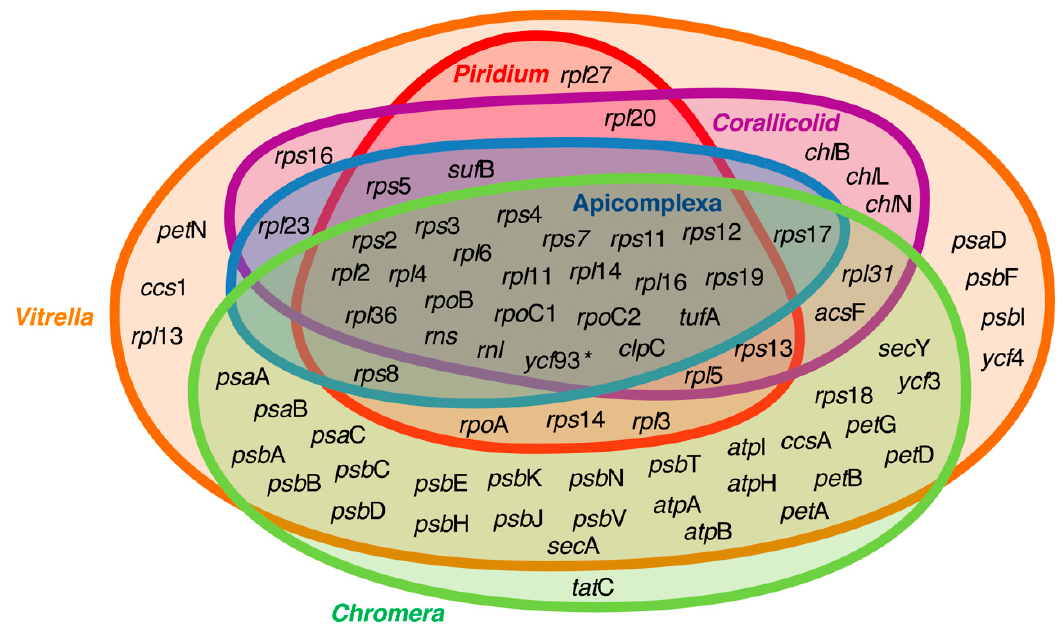
Figure 2. Venn diagram representing genes retained in the plastid genomes of apicomplexans and their close relatives. The overlapping rings show the core genes retained by the apicoplast, which primarily encodes genes for translation and replication, as well as suf B and clp C, which have been suggested to be essential for genes preventing plastid genome loss. The asterix next to ycf 93 signifies that the presence of this fast-evolving gene has not been explored in all lineages depicted in the diagram. Data for the figure were collected from Janouskovec et al., Mathur et al. [15,57], and the National Center for Biotechnology Information (NCBI) GenBank database.